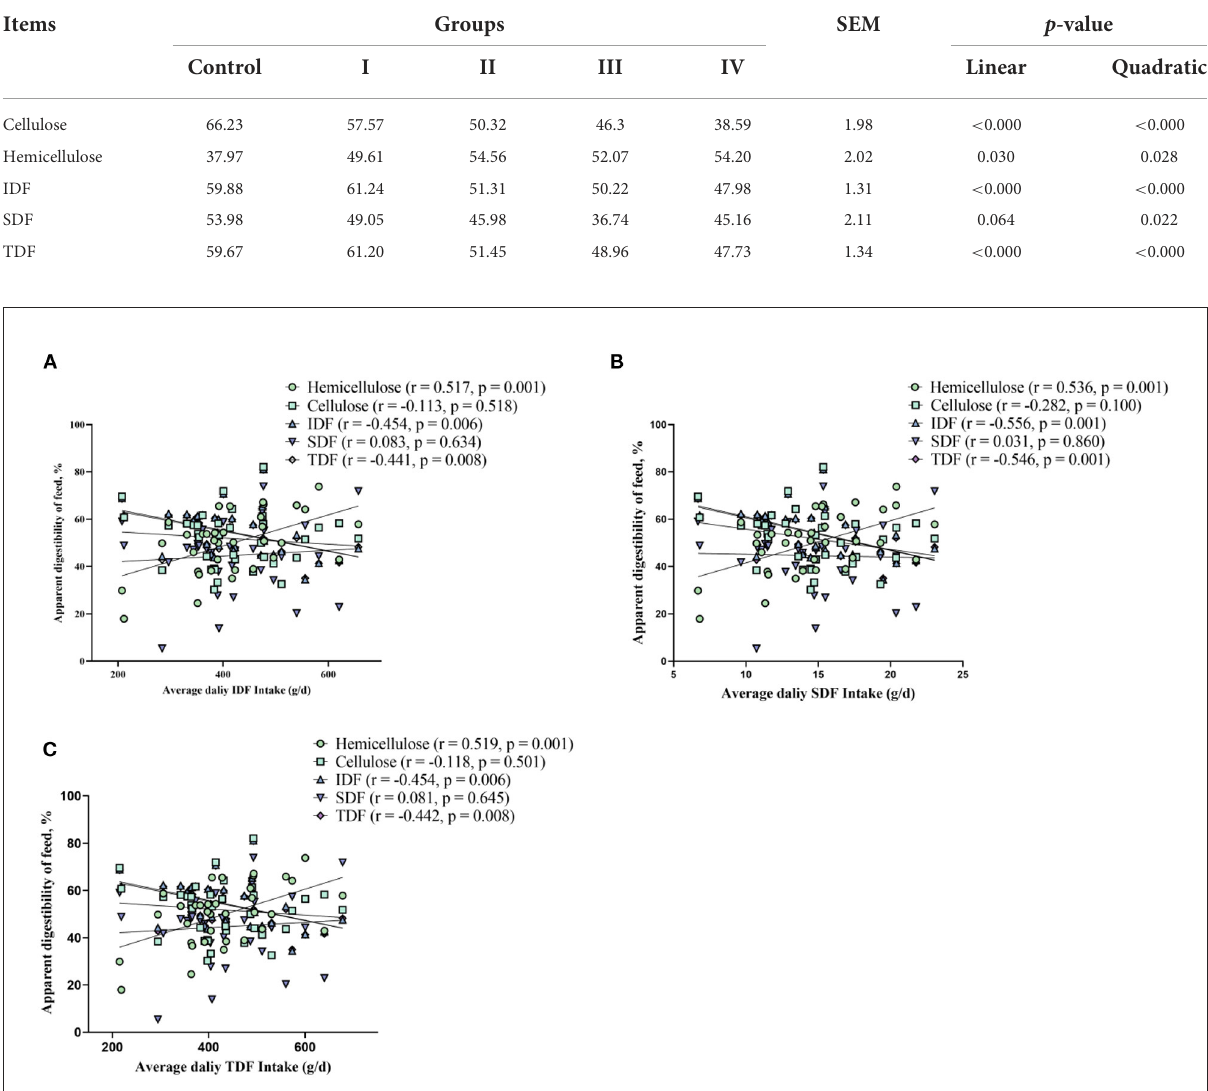
FIGURE1 Spearman’s correlation analysis between fiber apparent digestibility and average fiber intake of insoluble dietary fiber (A) , soluble dietary fiber (B) , and total dietary fiber (C) ,